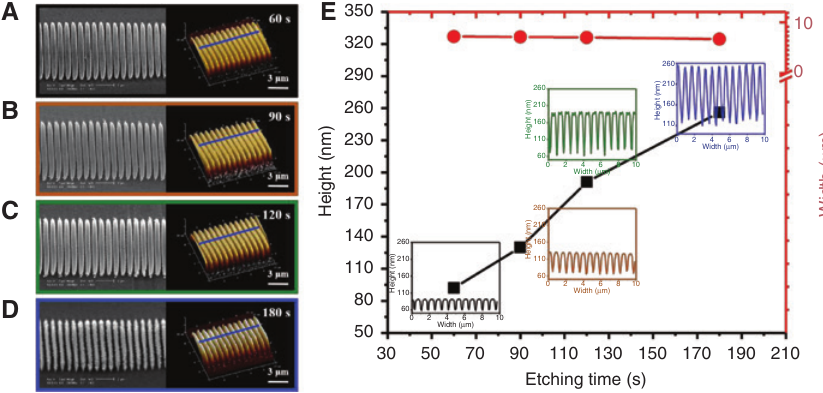
Figure 5: Morphology controllability of the nanograting structures. (A–D) SEM micrographs (left) and AFM images (right) of the nanogratings by different etching processes (etching for 60 s, 90 s, 120 s, and 180 s, respectively). (E) Topography dependence of silicon nanograting structures on etching time. The inserts are the corresponding cross-section images.